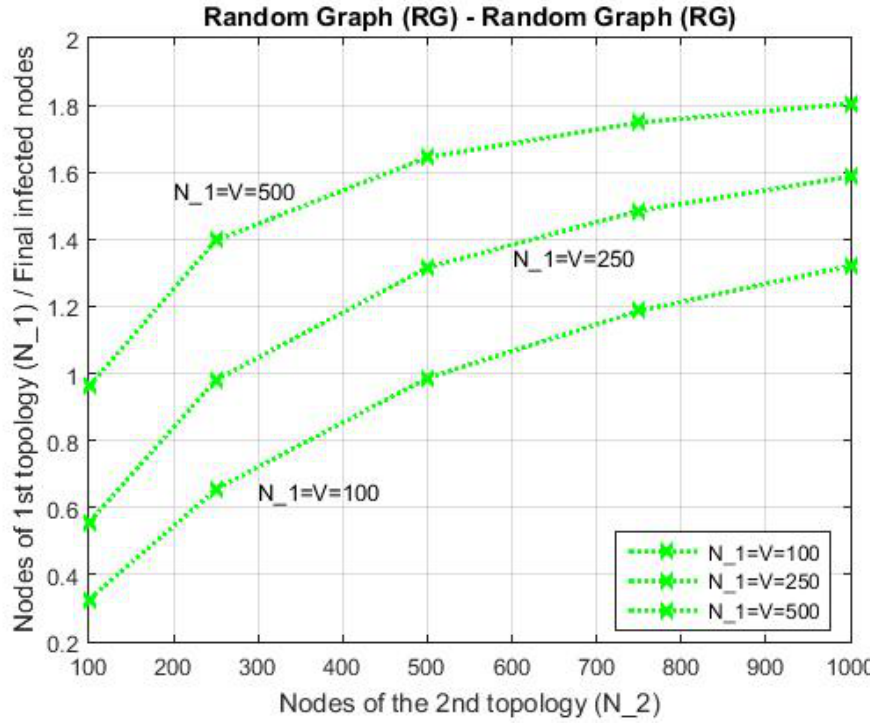
Figure 3. Random Graph with Random Graph, while N_1 = 100, N_1 = 250 and N_1 =